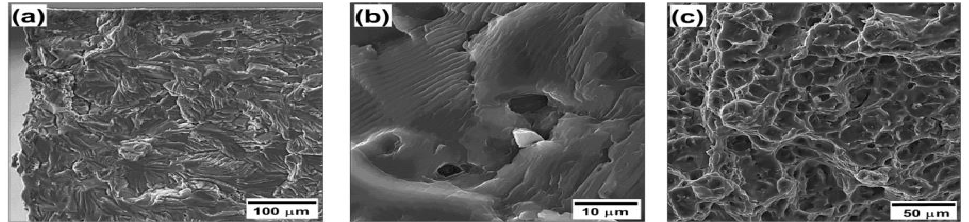
Figure 6. SEM micrographs illustrating fracture surface of friction-stir welded Al-Mg-Sc alloy in the cast initial condition fatigued at maximal cyclic stress of 140 MPa: ( a ) crack nucleation, ( b ) discontinuous crack propagation, and ( c ) catastrophic failure.